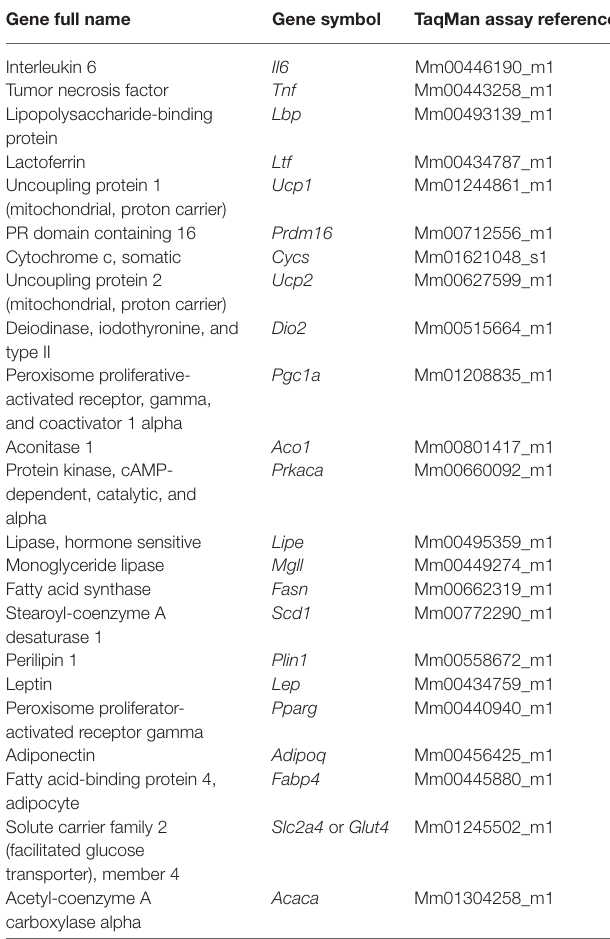
TABLE 1 | Description of TaqMan primer/probe sets used in gene expression